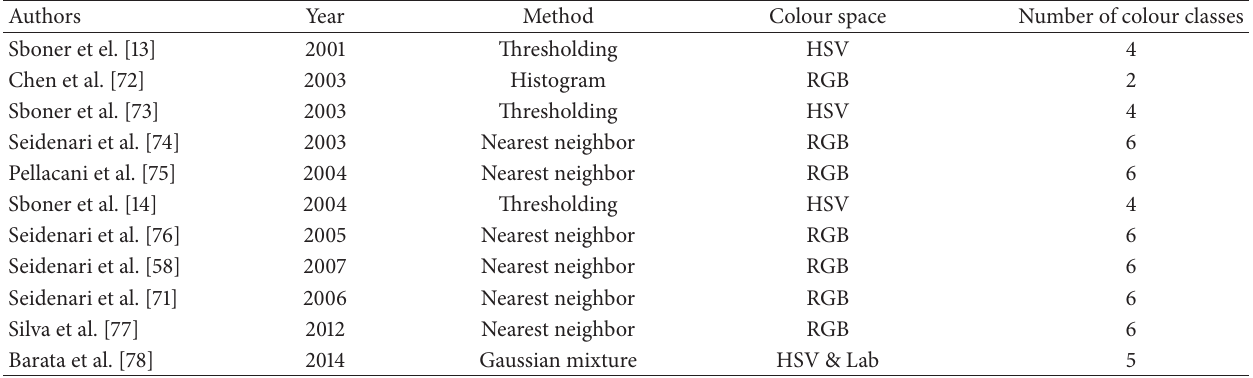
Table 3: Colour classification